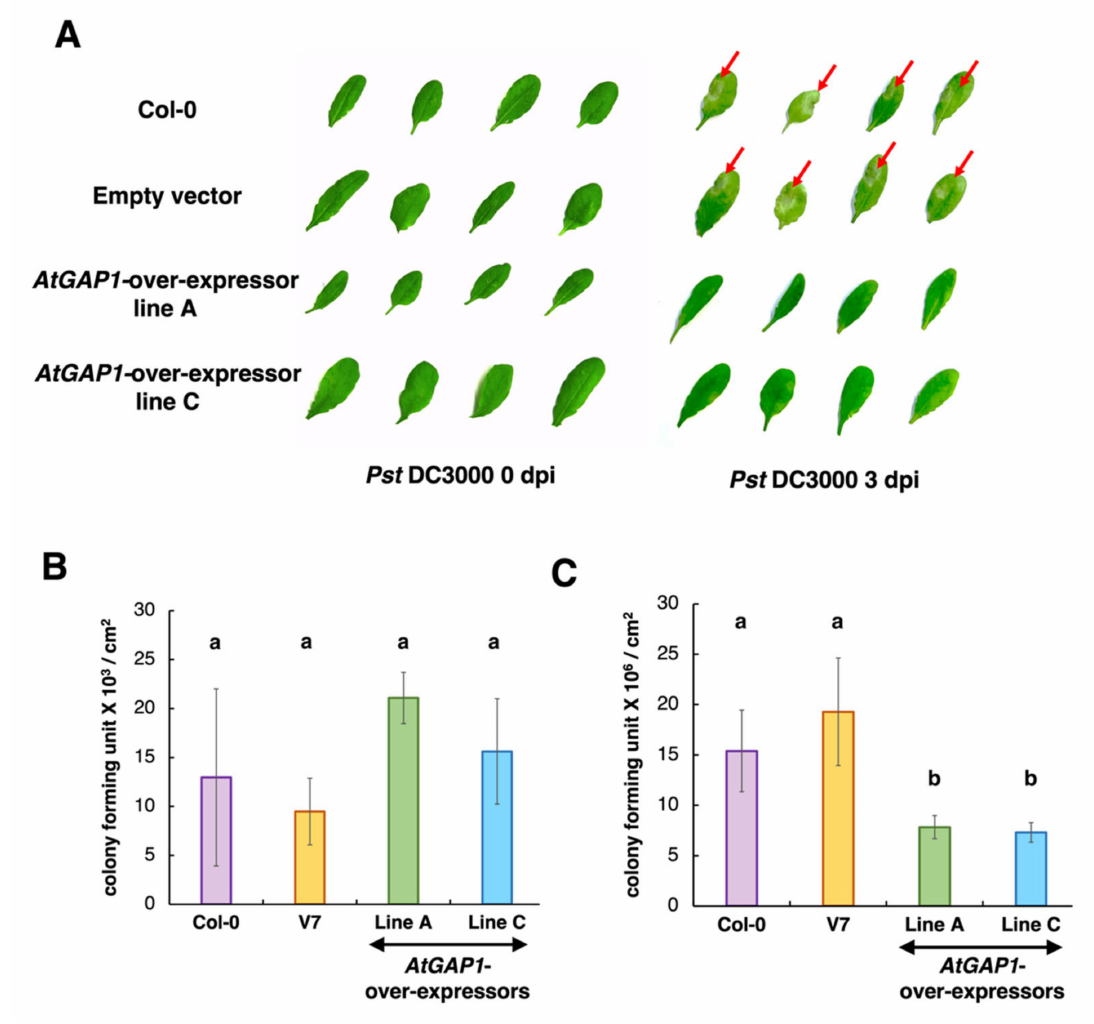
Figure 2. AtGAP1 -overexpressing Arabidopsis showed a more resistant phenotype to Pst DC3000 than wild type and the empty vector control. The rosette leaves of five-week-old Arabidopsis plants, including the wild type (Col-0), empty vector control (V7), and AtGAP1 -overexpressors (independent lines A and C) were inoculated with Pst DC3000. ( A ) The Pst DC3000-induced lesions in the rosette leaves at 0 and 3 days post-inoculation (dpi), indicated by red arrows. There were no visible lesions on the leaves of AtGAP1 -overexpressors at 3 dpi. ( B ) Pathogen titers of the inoculated rosette leaves expressed in colony-forming units per cm 2 of the leaf surface area at 0 dpi. ( C ) Pathogen titers of the inoculated rosette leaves at 3 dpi. ( B ) and ( C ) Different letters indicate significant differences at p < 0.05, using one-way ANOVA followed by post-hoc Tukey honestly significant difference (HSD) test. The results represent the average of three biological replicates. In each biological replicate, three individual plants were inoculated with Pst DC3000 for the pathogen titer analysis. Error bar: standard error; n = 9 plants from 3 biological